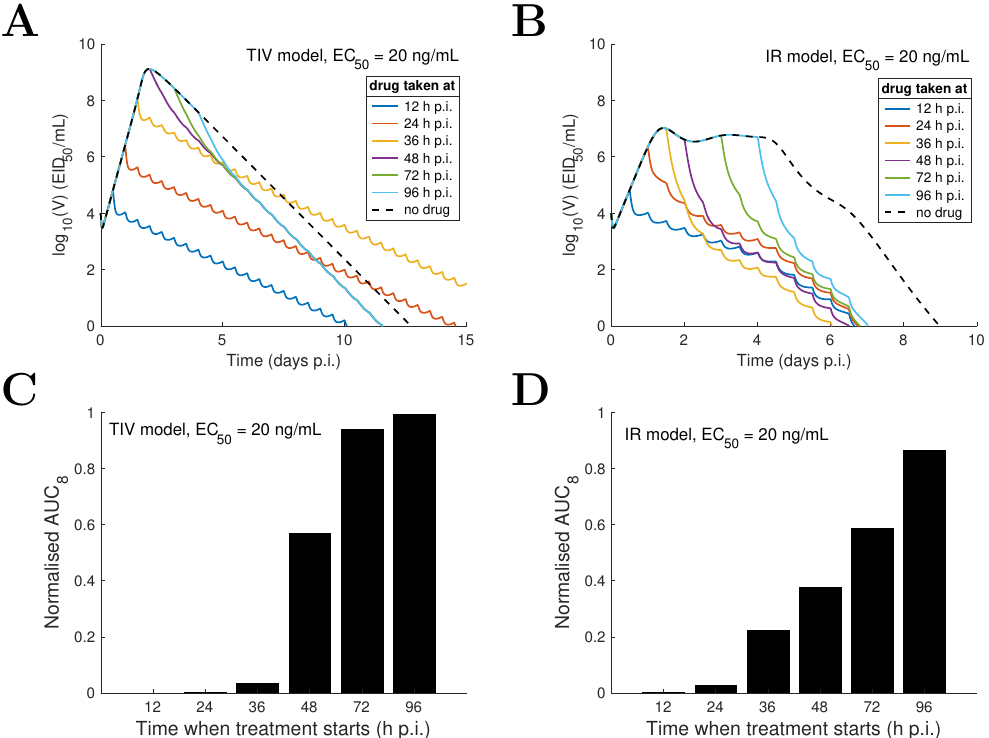
Figure 8. Comparison of model behaviours of the TIV model ( A , C ) and the IR model ( B , D ) for a highly effective drug ( EC 50 = 20 ng/mL) and varied drug administration time. The time when drug is first taken is varied from 12 h p.i. to 96 h p.i. and the corresponding viral load solutions are shown in different colours. AUC 8 is normalised to its corresponding quantity in the no-drug control. The solutions with no treatment are shown by dashed black